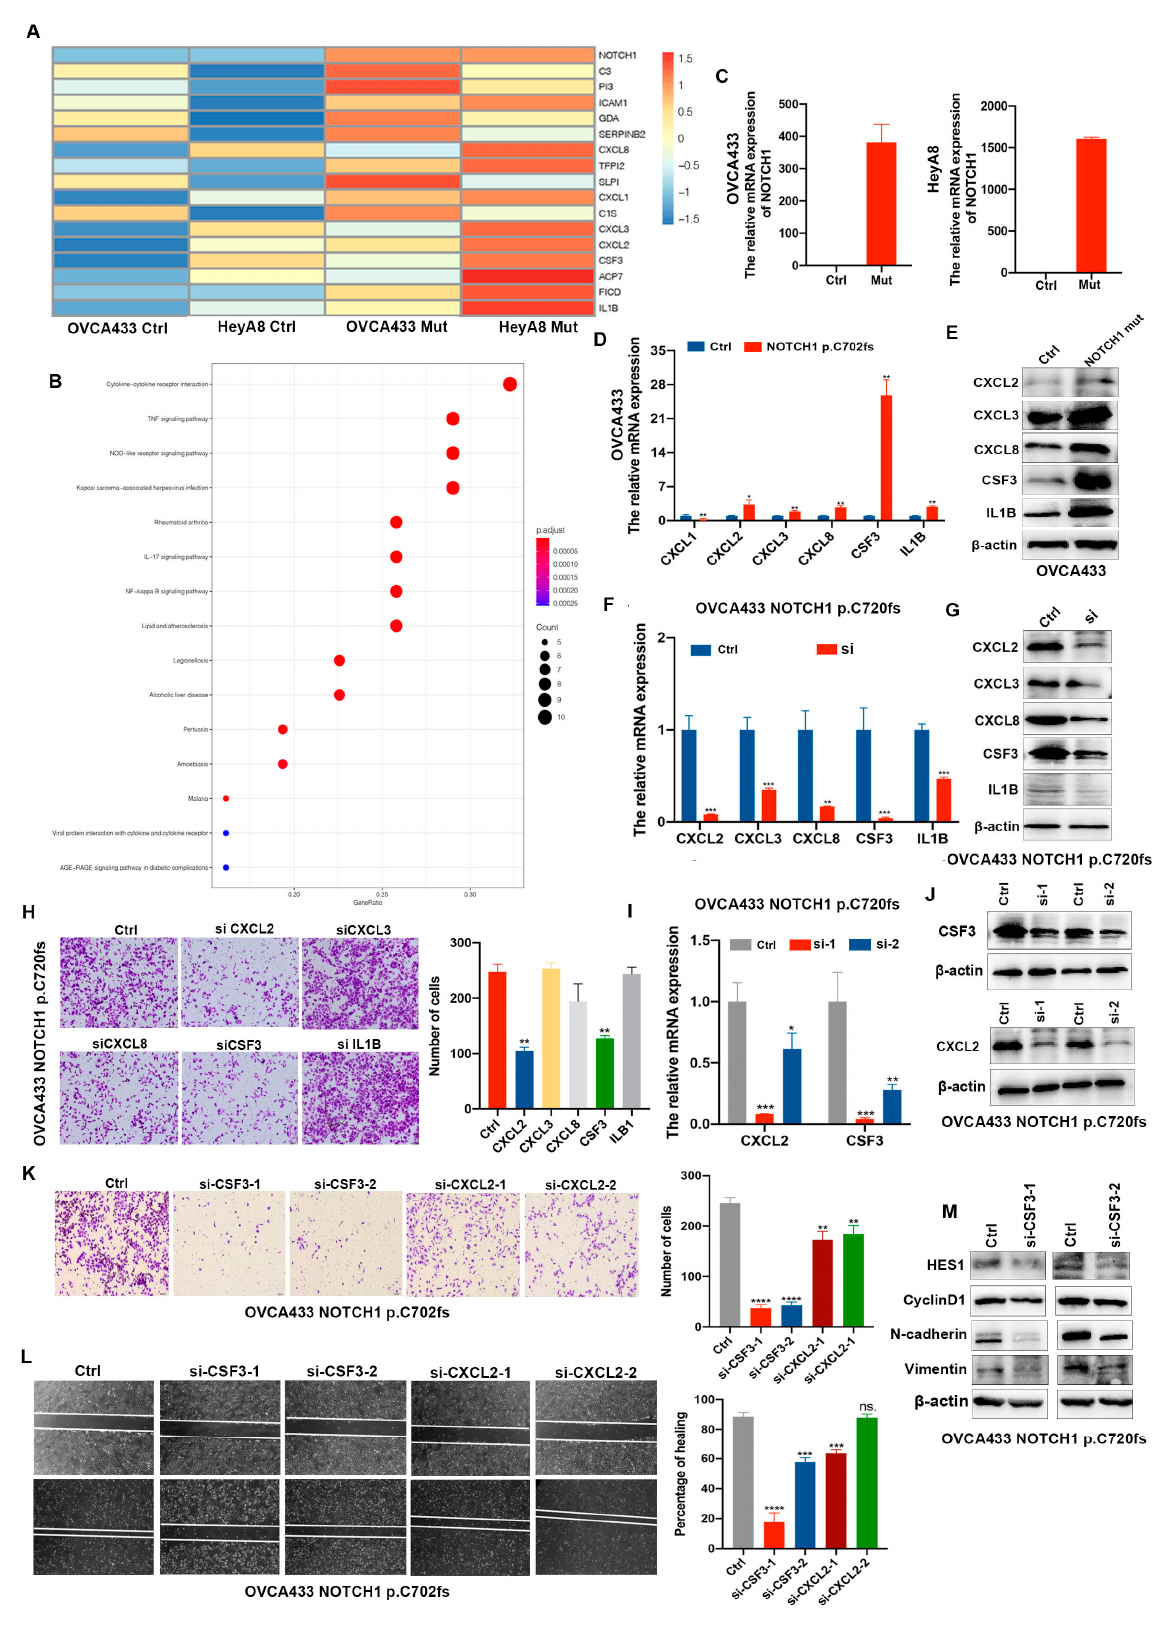
Figure 3. CSF3 is determined as the downstream effector of NOTCH1 -p.C720fs mutation on epithelial- mesenchymal transition. ( A , B ) CXCL1 , CXCL2 , CXCL3 , CXCL8 , CSF3 and IL1B were